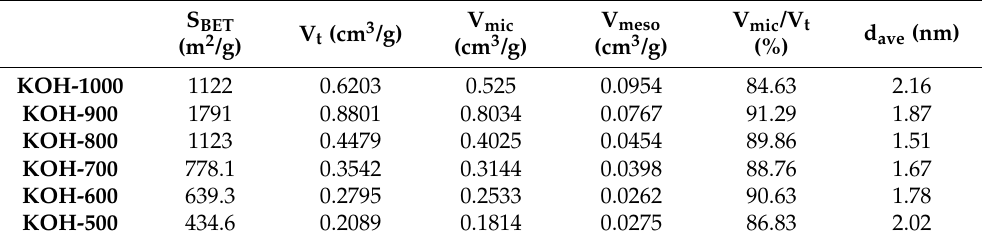
Table 2. The specific surface area, pore volumes of ACs with KOH prepared at different temperatures. S BET (m 2